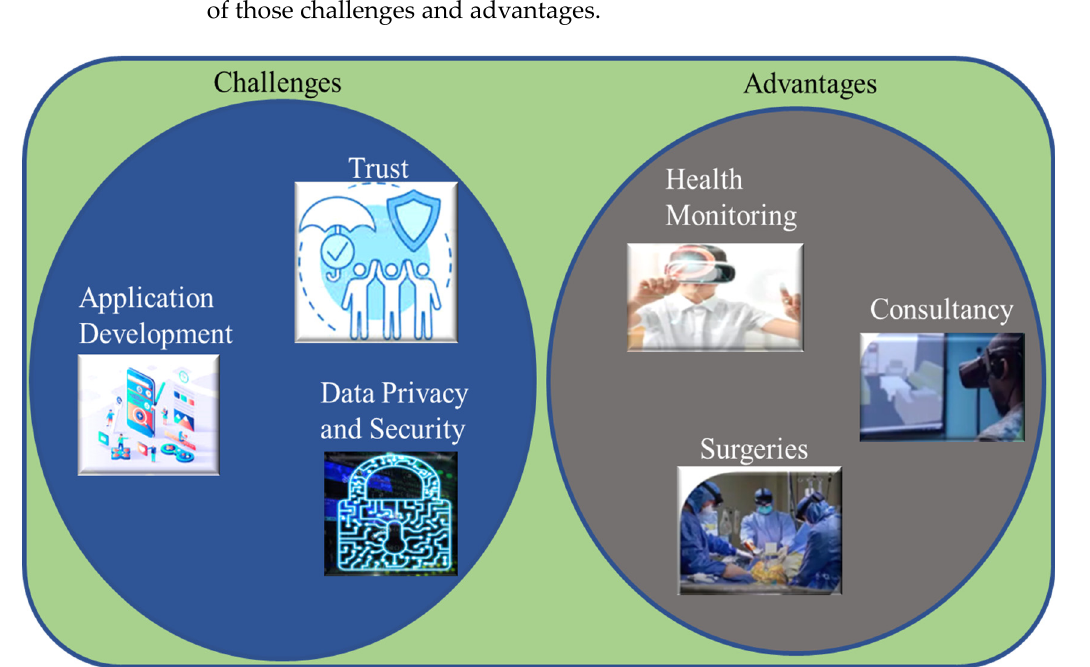
Figure 3. Challenges and advantages of metaverse in